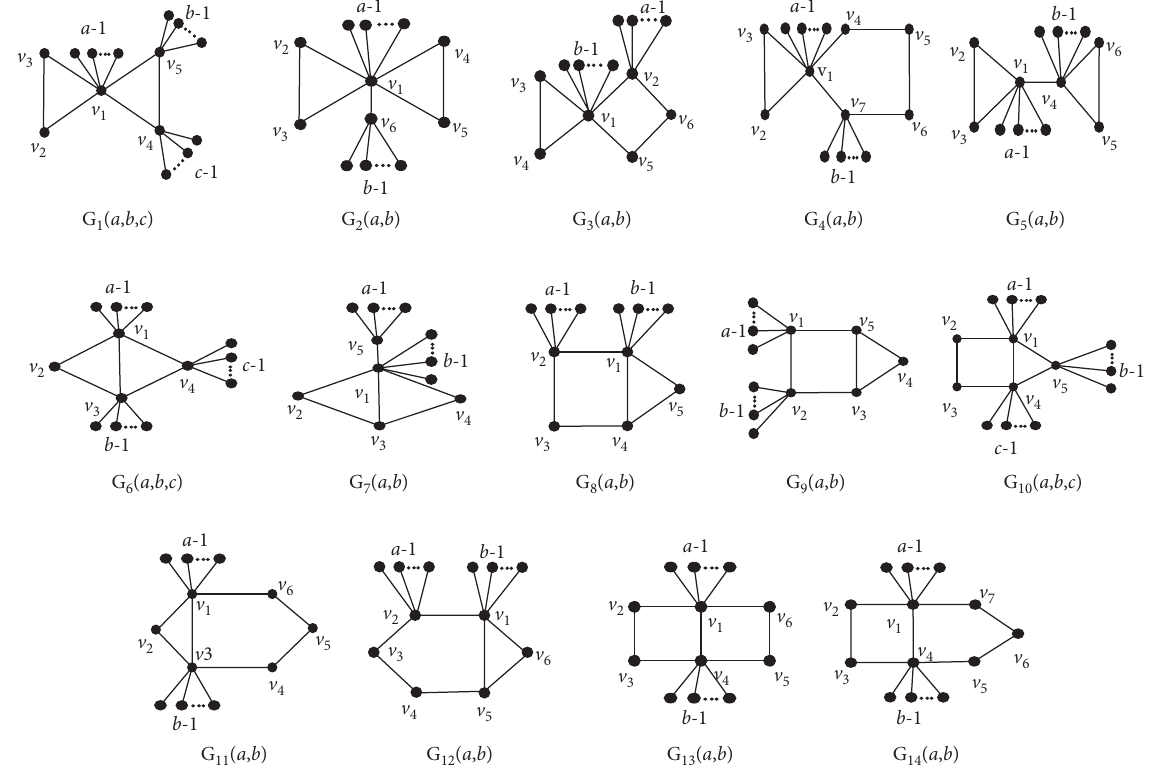
Figure 1: All bicyclic graphs G